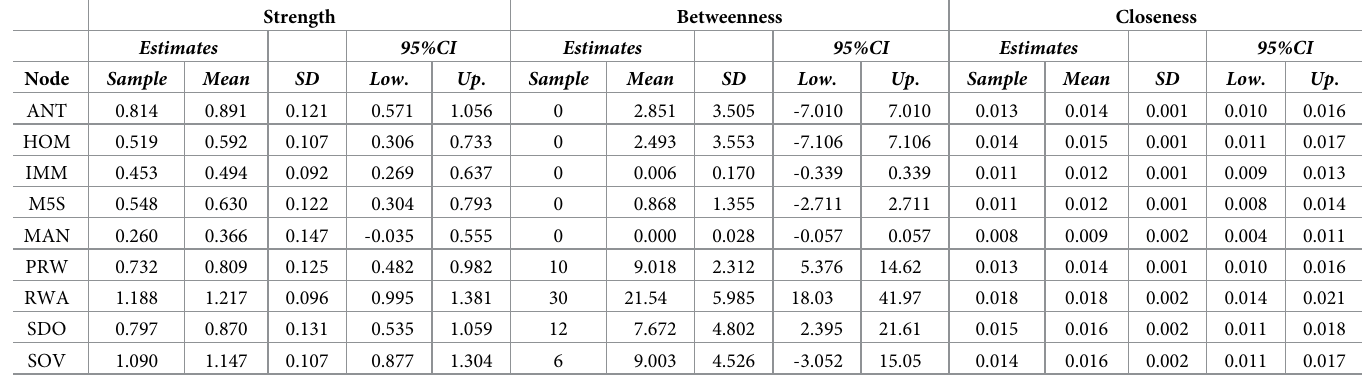
Table 8. Sample and bootstrap mean of centrality indices of the integrated beliefs system network including ideological attitudes, anti-immigration attitudes, popu- list ideology and voting. Strength Betweenness Closeness Estimates 95%CI Estimates 95%CI Estimates 95%CI Node Sample Mean SD Low . Up . Sample Mean SD Low . Up . Sample Mean SD Low . Up .